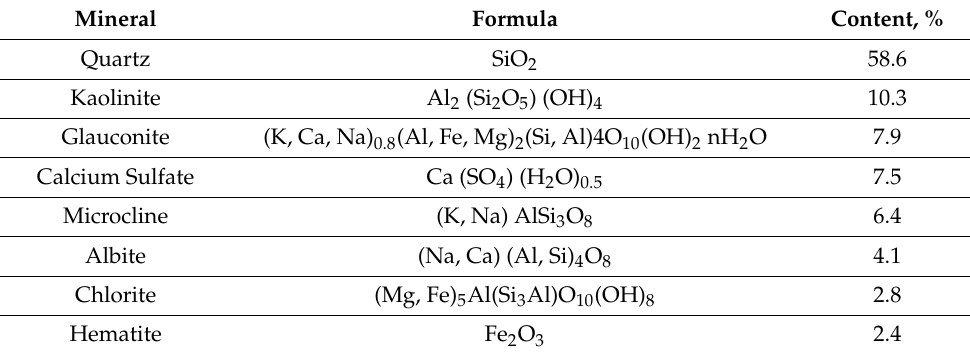
Figure 1. Diffractogram of the initial core material sample. Table 3. Results of analysis of quantitative and qualitative characteristics of samples.